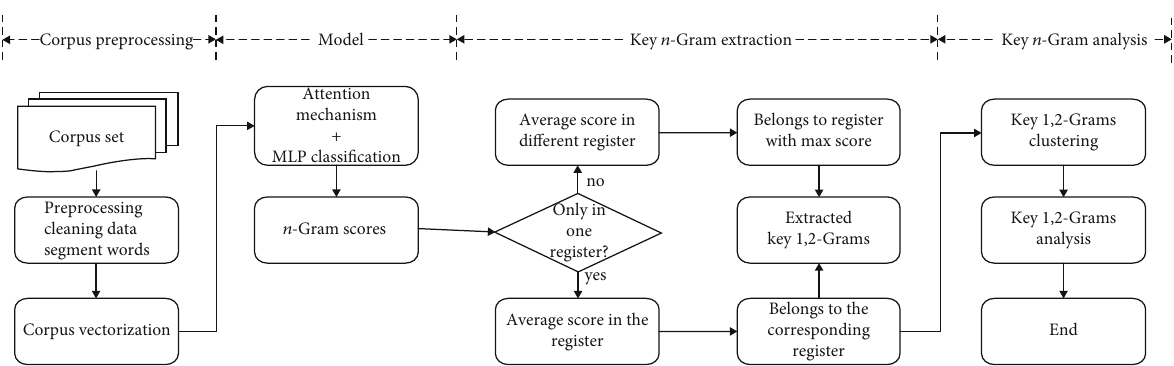
Figure 2: Keyword and 2-gram extraction fl ow chart.